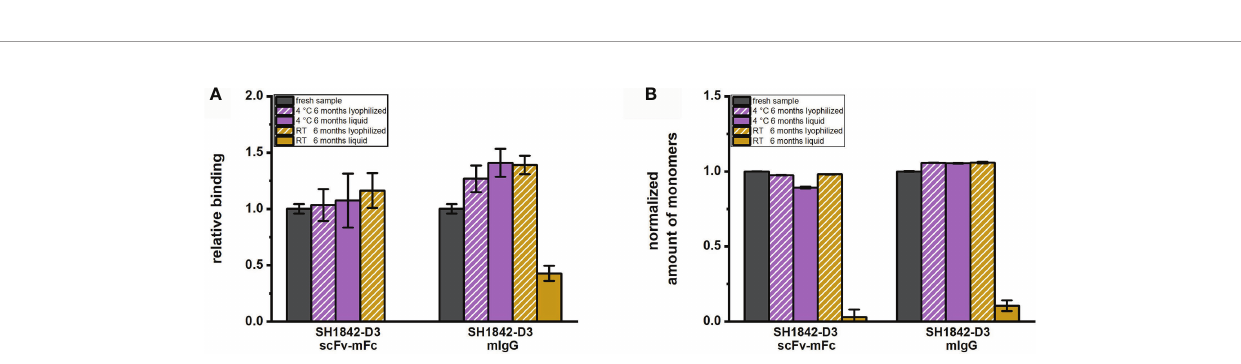
FIGURE 6 | Six months storage impact on mAb activity and molecular species composition. (A) Bar chart representing binding measured in titration ELISA on 100 ng immobilized antigen. EC 50 values as quanti fi cation of the relative antibody af fi nity were reciprocally normalized to the reference material (fresh sample). (B) In the bar chart is shown the monomer percentage per each antibody stored in different conditions as indirect measure of aggregation or degradation occurred over time and normalized to the monomer percentage of the fresh sample. Error bars result from the analysis of 2 to 3 independently lyophilized or liquid stored